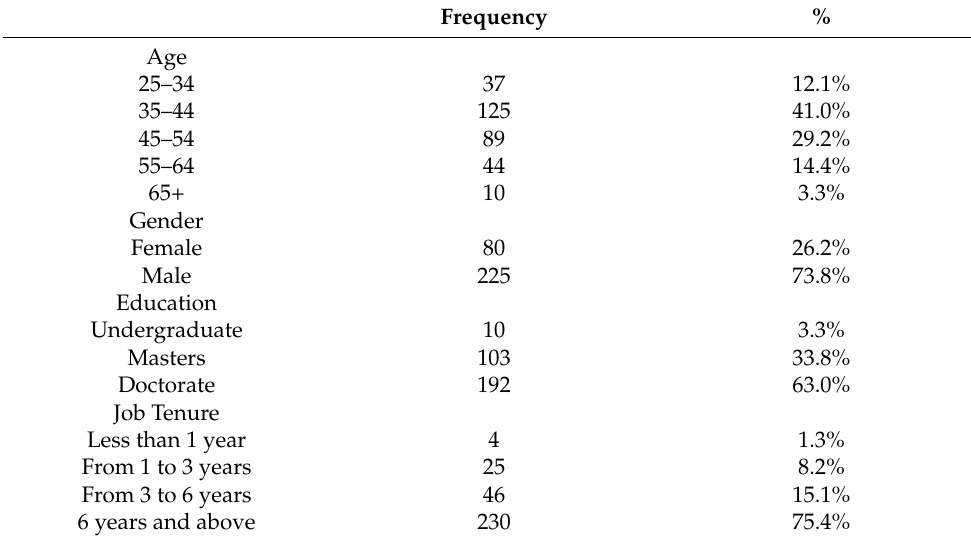
Table 1. Demographic